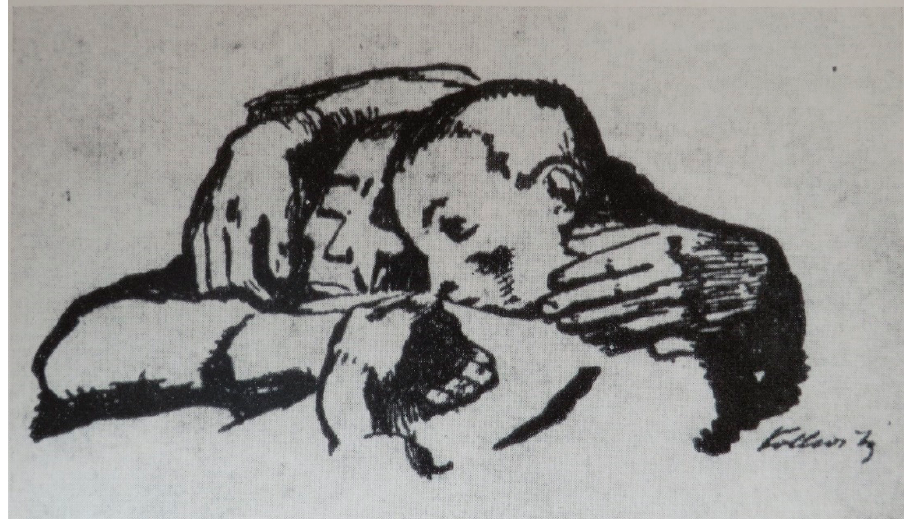
Figure 1. Käthe Kollwitz, Two Dead [Zwei Tote], 1920. Pen and ink, dimensions unknown. According to (Nagel 1972), the original drawing is lost. Image source: (Nagel 1972, p. 355).